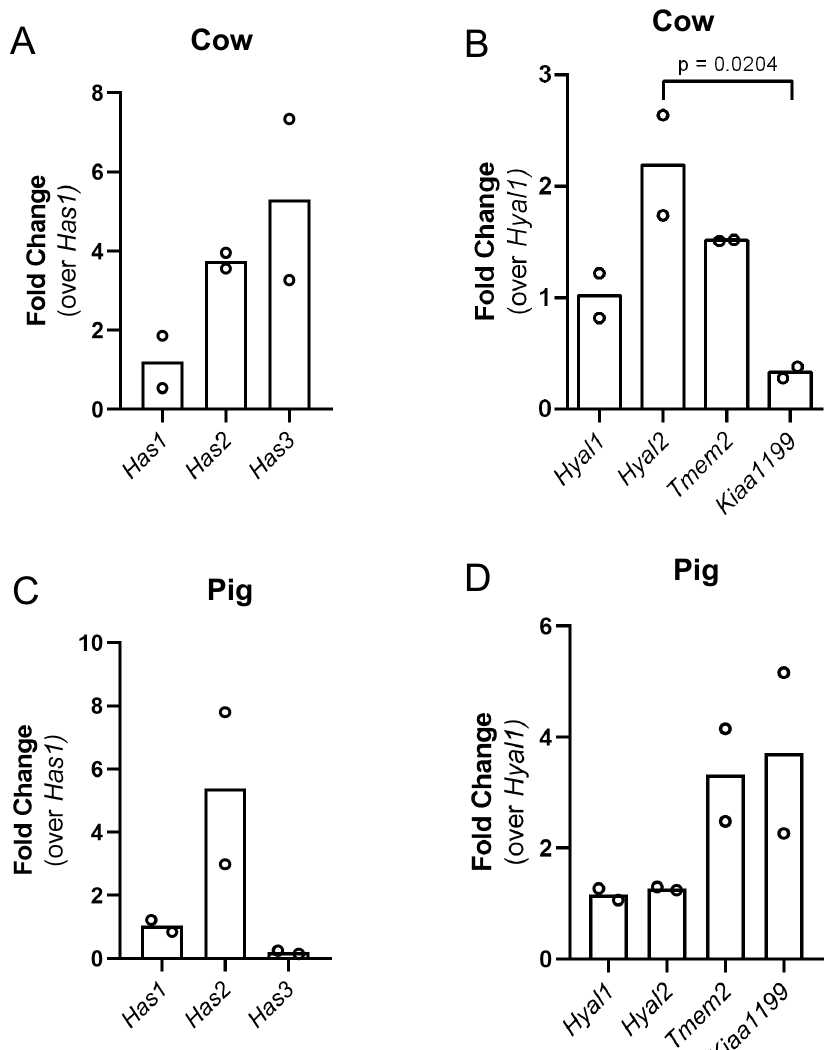
Figure 8. Bovine ovarian stroma and porcine ovaries hyaluronan synthase and hyaluronidase transcript content. Relative hyaluronan synthase gene expression in ( A ) cows and ( C ) pigs. Relative hyaluronidase gene expression in ( B ) cows and ( D ) pigs. Hyaluronan synthase transcript data are shown as fold change over Has1 , while hyaluronidase transcript data are shown as a fold change over Hyal1 . n = 2 cow ovaries, n = 2 pig ovaries. Circles represent values from individual animals. Statistical analysis was performed using a one-way ANOVA. The p -value is as